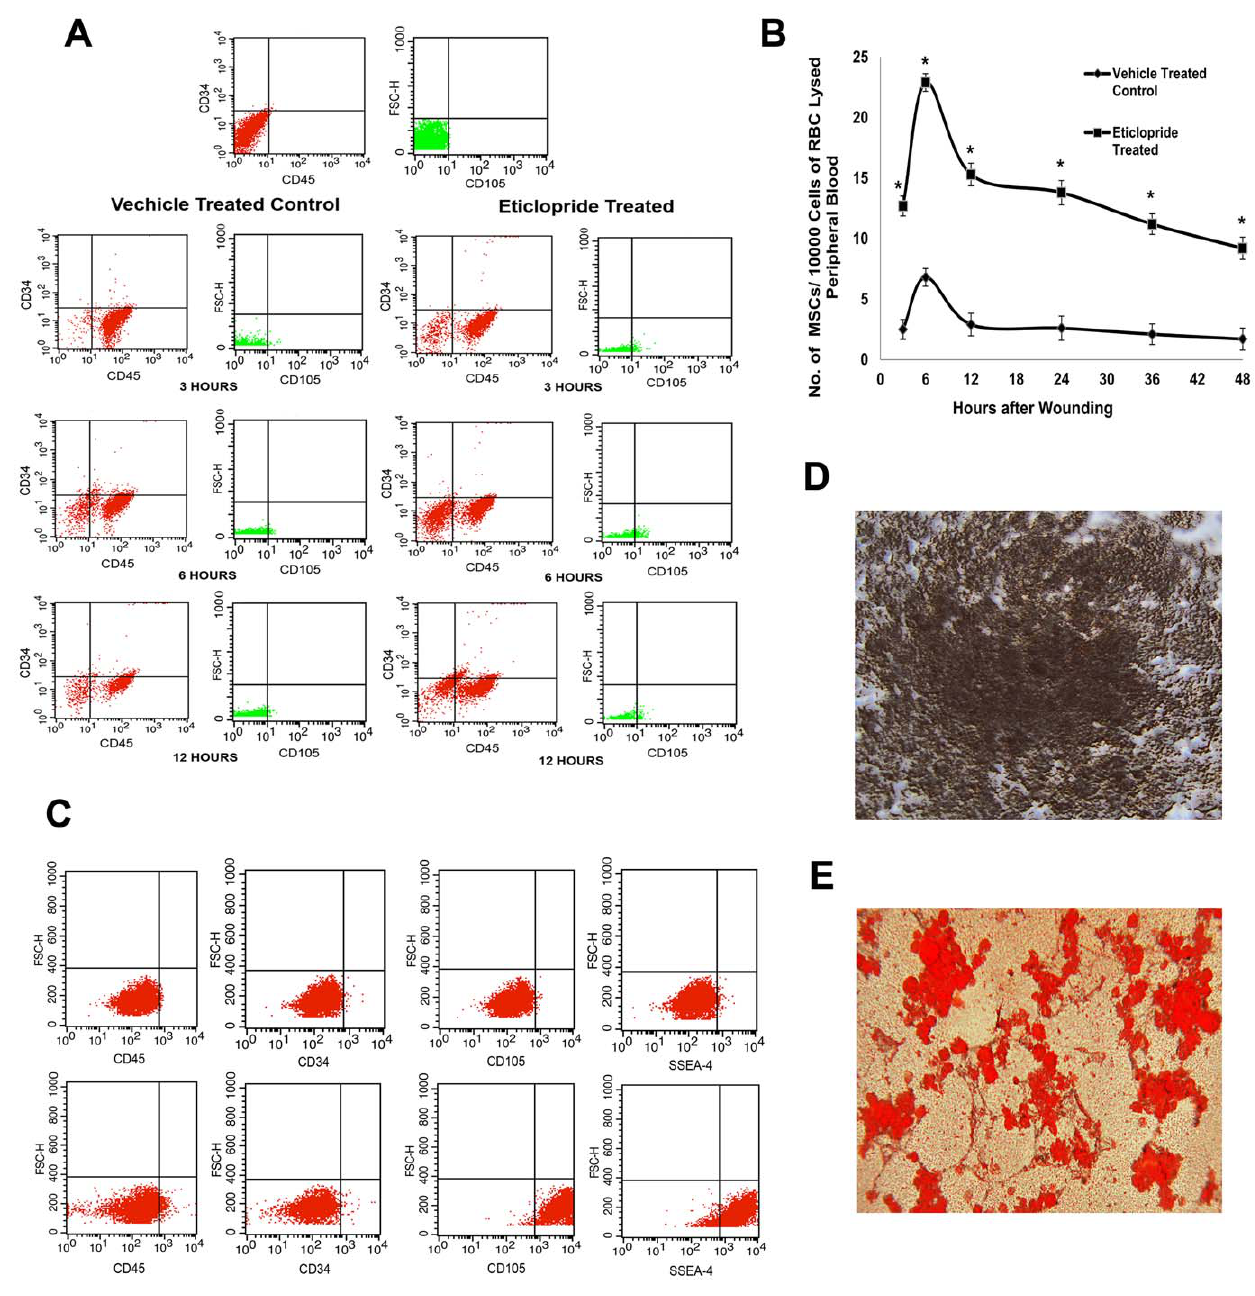
Figure 1. Treatment with dopamine (DA) D 2 receptor specific antagonist significantly increased the number of circulating MSCs in peripheral blood of wound bearing mice. ( A ) Effect of eticlopride (DA D 2 receptor specific antagonist) on the number of circulating MSCs in peripheral blood of wound bearing mice. Blood was collected from both the control and eticlopride treated wound bearing mice at different time intervals after injury, mixed with EDTA, treated with RBC lysis buffer and incubated with anti-CD45, anti-CD34 and anti-CD105 antibodies. Cells were initially gated to exclude dead cells and debris and then the CD34 2 CD45 2 cell population was selected and evaluated for presence of CD105, a specific surface marker of MSCs. Results are representative of six separate experiments each yielding similar results. ( B ) Graph showing that DA D 2 receptor antagonist treatment have significant positive regulatory effect on MSC mobilization as significantly higher number of MSCs (CD34 2 CD45 2 CD105 + cells) was evident in peripheral blood of mice compared to vehicle treated controls at all time points after wounding. (*, P , 0.05). ( C ) Characterization of MSCs by flow cytometry. Analysis with flow cytometer showed that over 95% cells of the total 3rd passage murine bone marrow cell populations were positive for both SSEA-4 and CD105 (specific surface markers of MSCs) and negative for CD34 and CD45, thus confirming their identity as MSCs. BM-MSCs were cultured in appropriate induction media to evaluate osteogenic and adipogenic differentiation potential of these stem cells and were confirmed by von Kossa staining (D) and Oil-red O staining (E) respectively. ( D ) To confirm osteogenic differentiation, mineralized deposits in the extracellular matrix were visualized by von Kossa staining. Differentiated cells were fixed with 4% paraformaldehyde, washed and then stained with 5% silver nitrate (Sigma) solution in the absence of light at room temperature for 30 minutes. Cells were then exposed to sunlight for 5 minutes and excess silver staining was removed by washing 2–3 times with a 5% sodium thiosulfate solution and ultimately washed with distilled water. ( E ) Adipogenic differentiation of cultured MSCs was confirmed by Oil-red O staining. Cells were fixed with 4% paraformaldehyde and washed